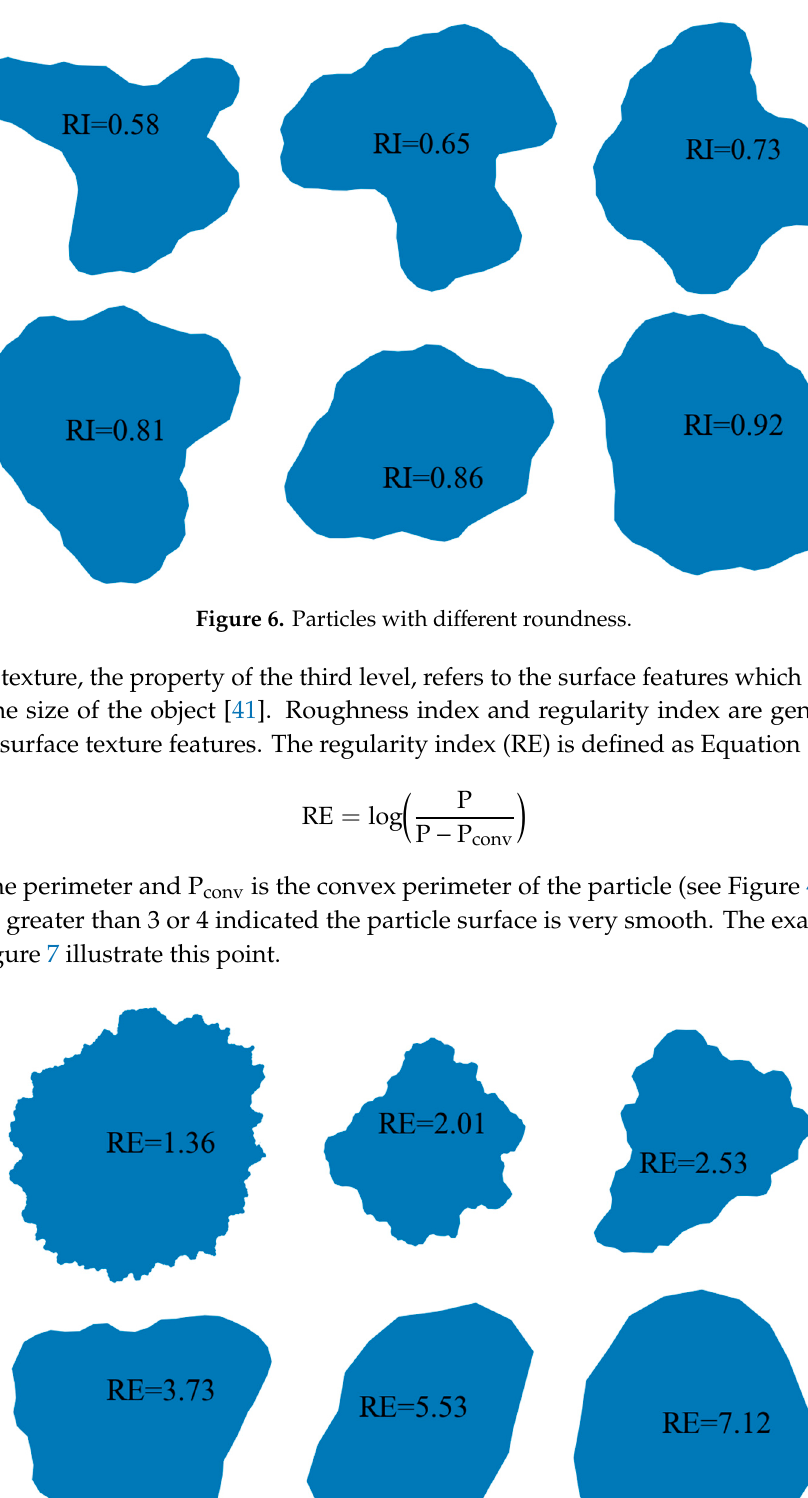
Figure 7. Particles with different regularity.